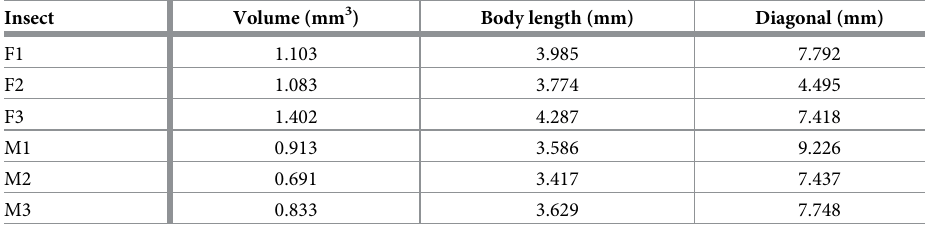
Table 2. Volumes and lengths of